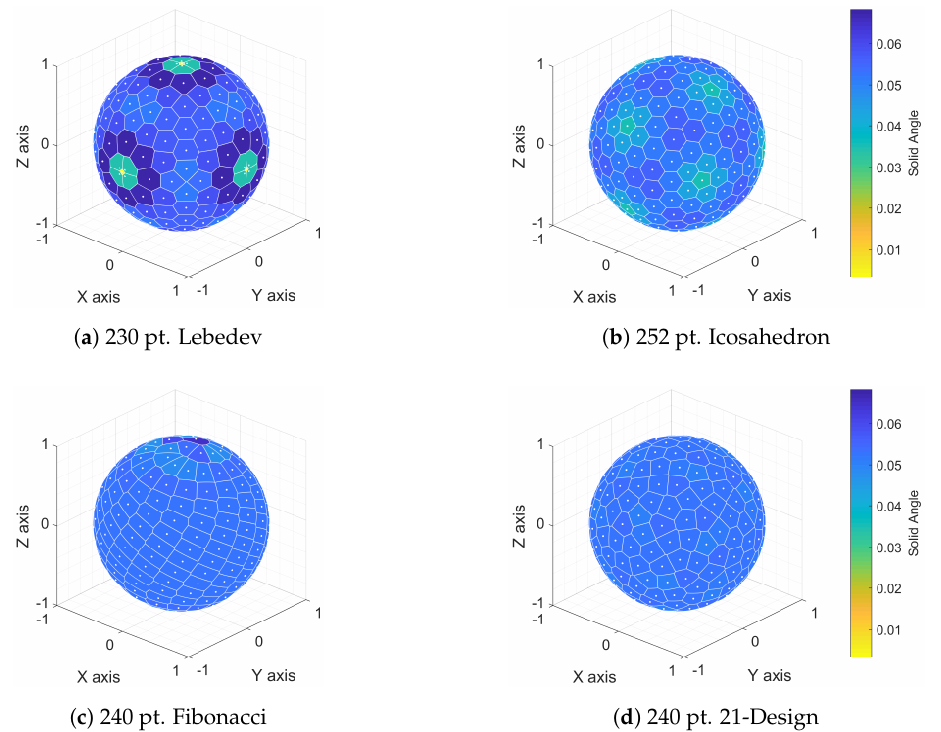
Figure 3. Voronoi sphere plots demonstrating the regularity in spherical distribution of points for four quadrature methods: ( a ) 230 pt. Lebedev, ( b ) 252 pt. Icosahedron, ( c ) 240 pt. Fibonacci and ( d ) 240 pt.